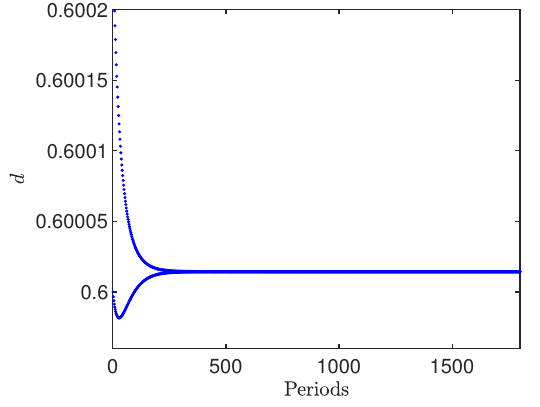
Figure 8. Evolution of the duty